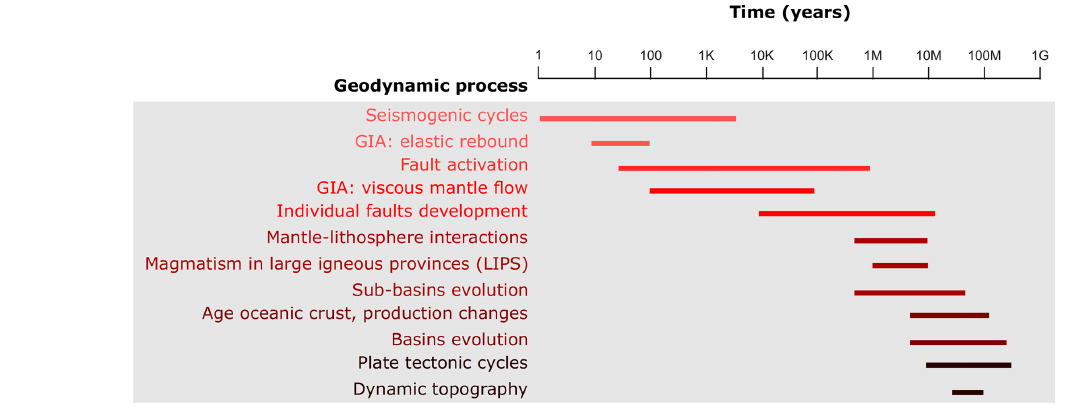
Figure 11. Temporal variability of the main periodic geodynamic mechanisms (based on Matenco and Haq, 2020).